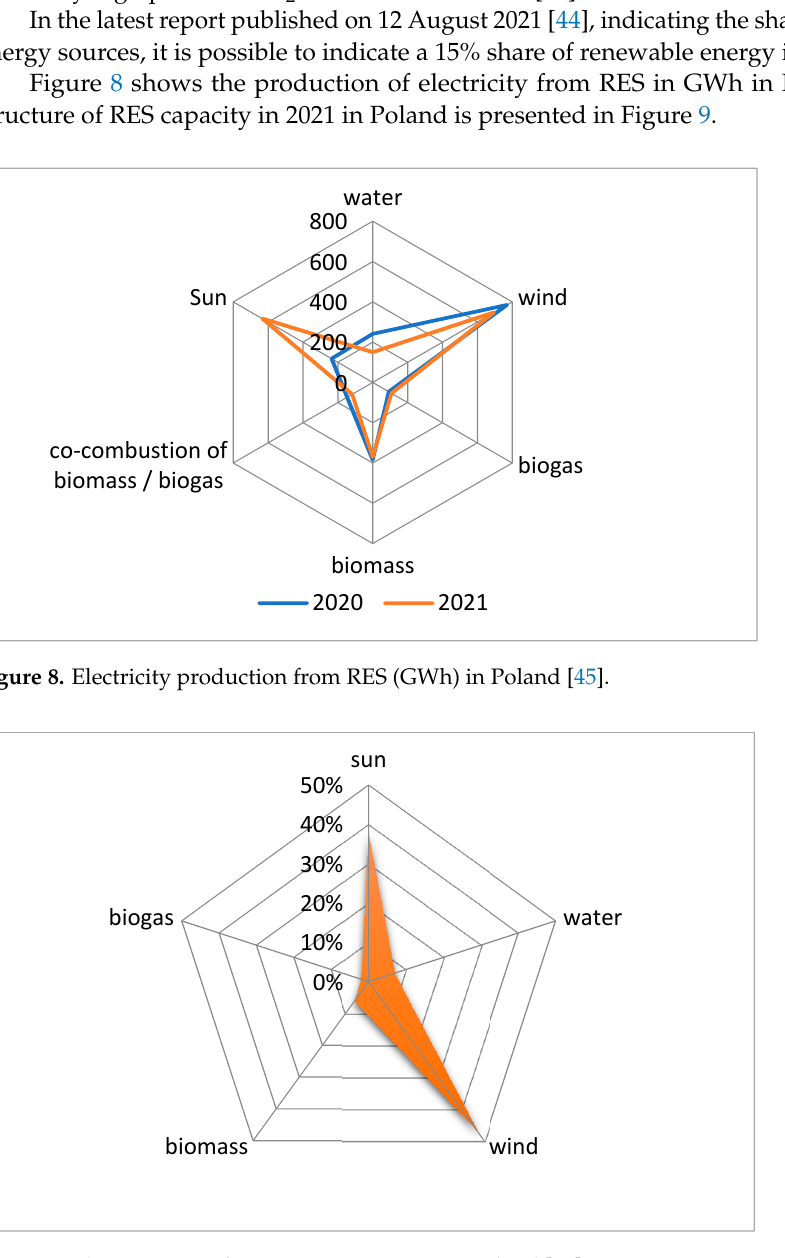
Figure 10. KSE operation—generation of wind and photovoltaic sources [47]. The percentage share in the national electricity production of individual groups of power plants by fuel type in 2019 is presented in figure 11, when in 2019, the share of energy generated by hard coal-fired commercial power plants was the largest (almost 50%). Lignite-fired utility power plants were next (26.14%). The next share oscillated around 10%, and these were, successively: wind and other renewable power plants, com- mercial gas power plants and industrial power plants. The smallest share was that of com- mercial hydropower plants (1.55%).